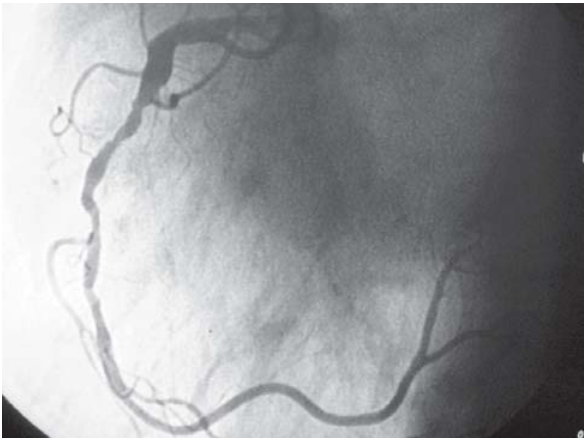
Fig. 3 - Cinecoronariografia demonstrando lesões seqüenciais em artéria coronária direita